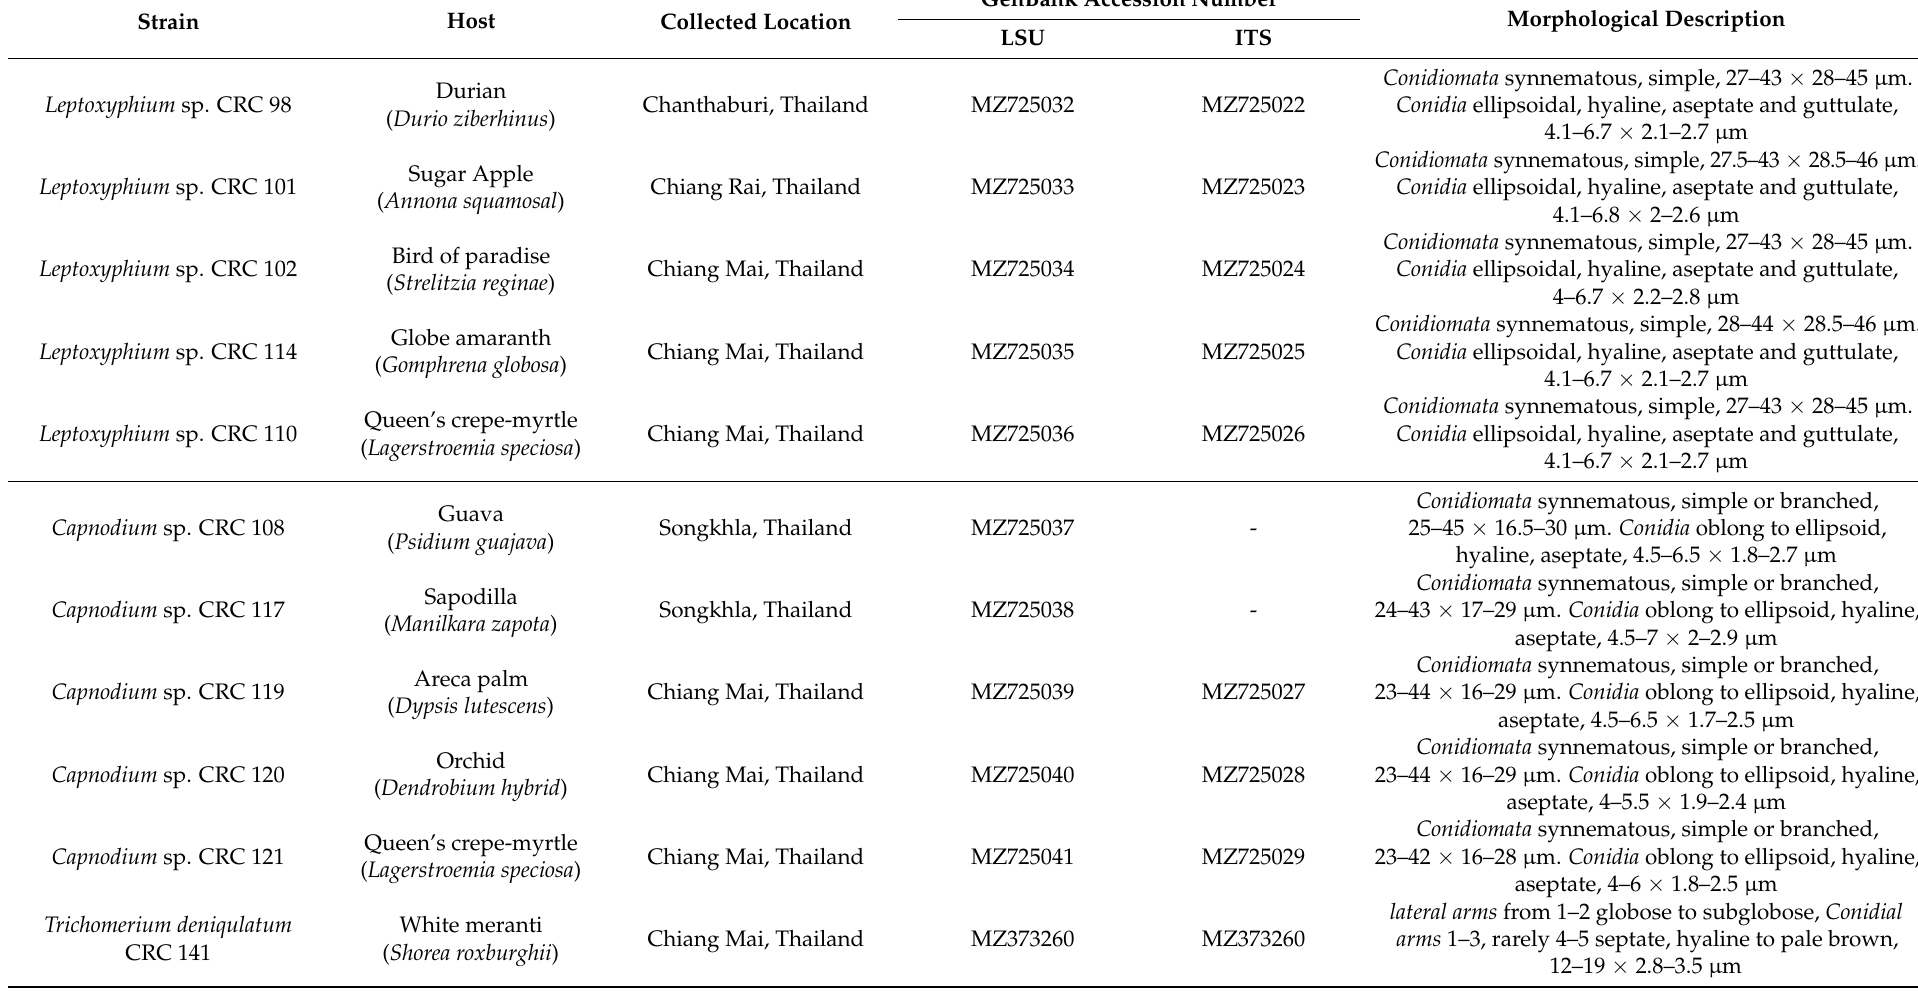
Table 1. Morphology, host information, locality and accession number of sooty molds generated in this